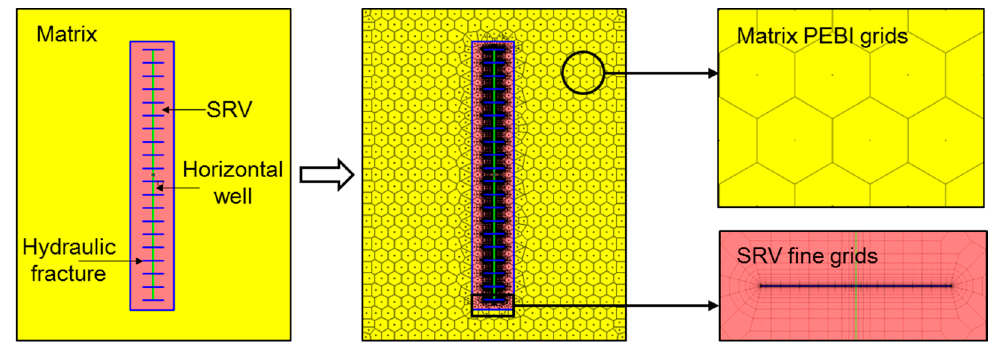
Figure 2 . Perpendicular bisection (PEBI) meshing grids of HFs and matrix. Figure 2. Perpendicular bisection (PEBI) meshing grids of HFs and